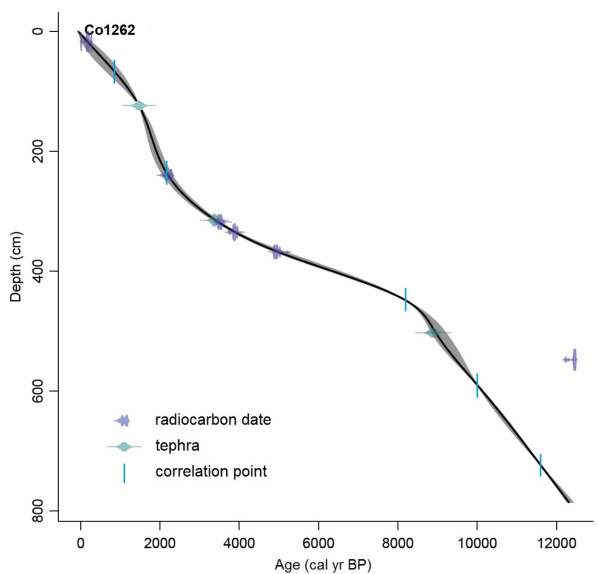
Figure 2. Age–depth model of core Co1262 (modified from Lacey et al.,